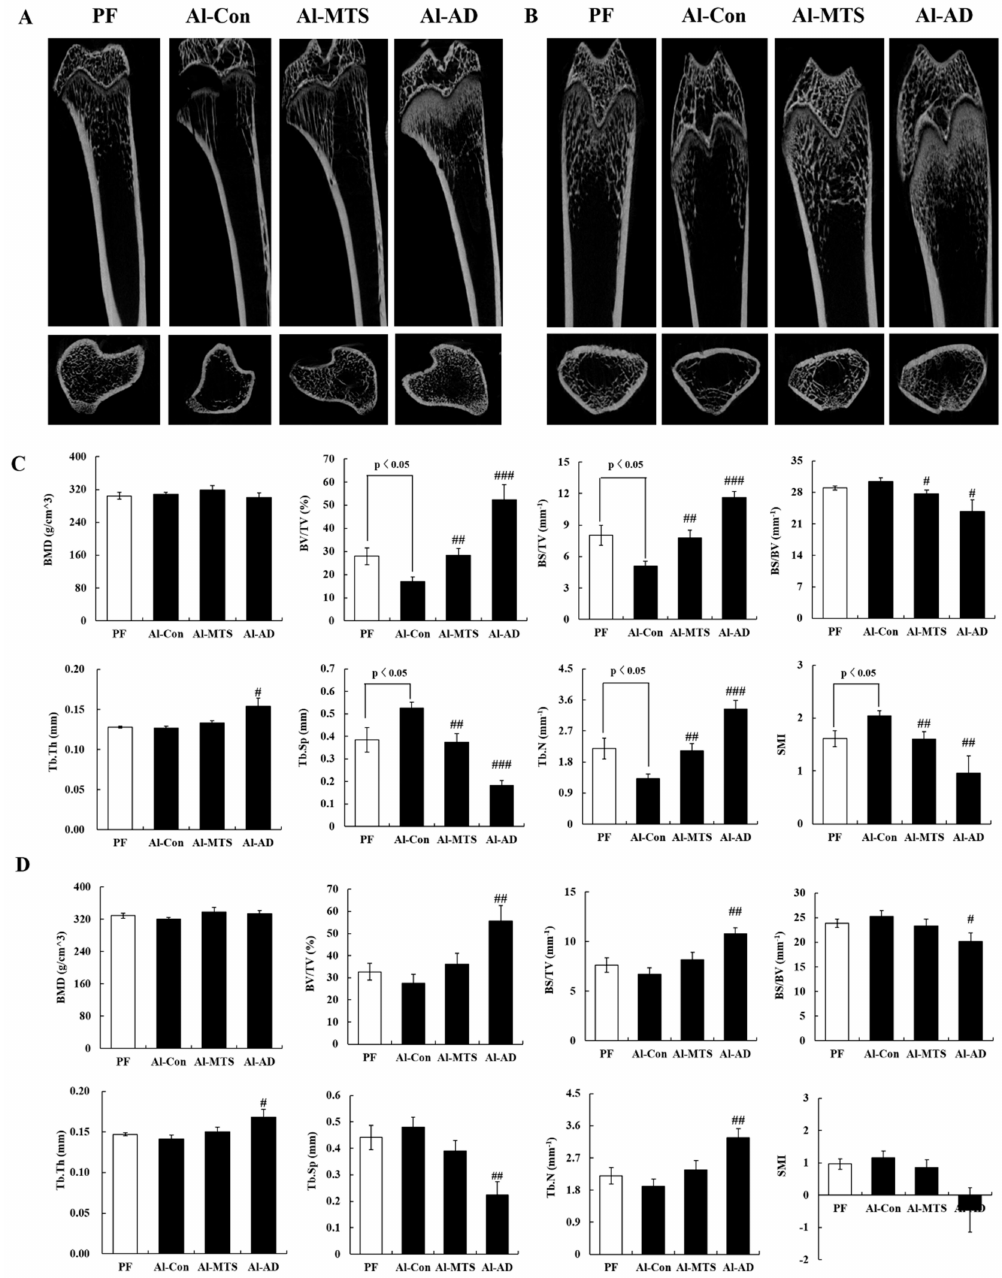
Figure 1. E ff ect of methoxsalen supplementation on the tibia micro-CT image ( A ), femur micro-CT image ( B ), tibia microarchitecture parameters ( C ) and femur microarchitecture parameters ( D ) in chronic alcohol-fed rats. The values are expressed as the mean ± S.E. # p < 0.05, ## p < 0.01 and ### p < 0.001 vs. Al-Con according to a Student’s t -test. PF; pair-fed, Al-Con: alcohol control, AL-MTS: alcohol supplemented with methoxsalen and Al-AD: